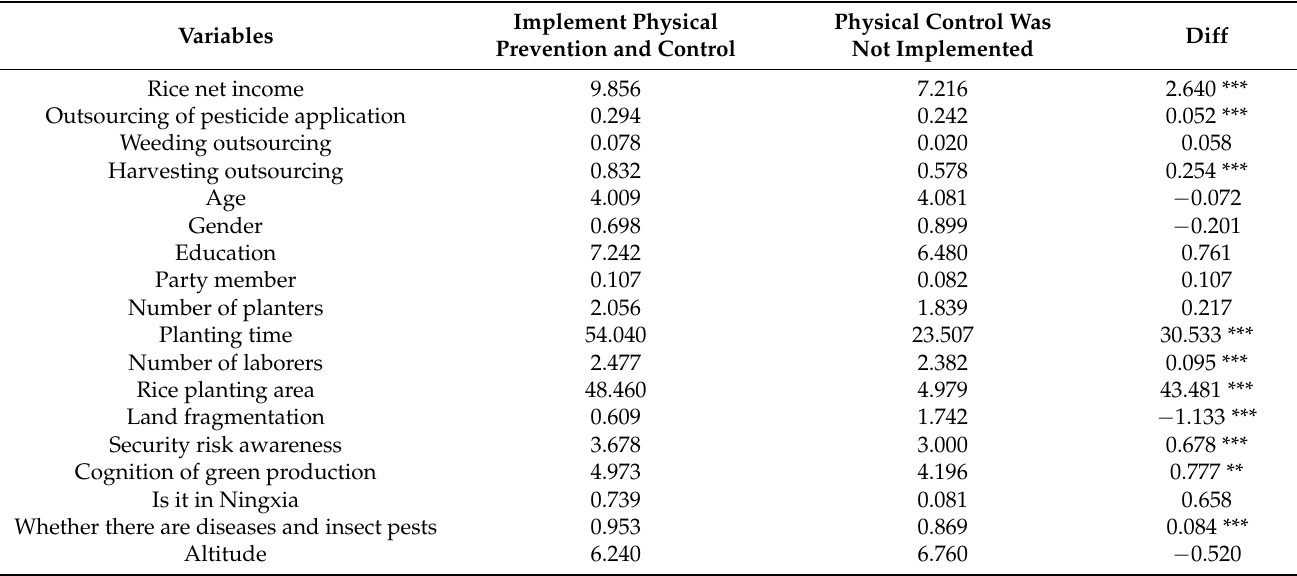
Table 4. Variable descriptive statistics and differences between rice farmers who implemented and did not implement physical control behaviors.